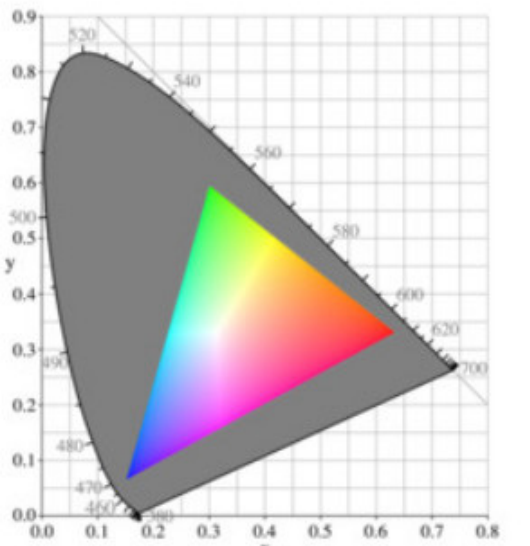
Figure 4: The colour gamut of a CRT computer monitor pro- jected onto a 1931 CIE chromaticity diagram.